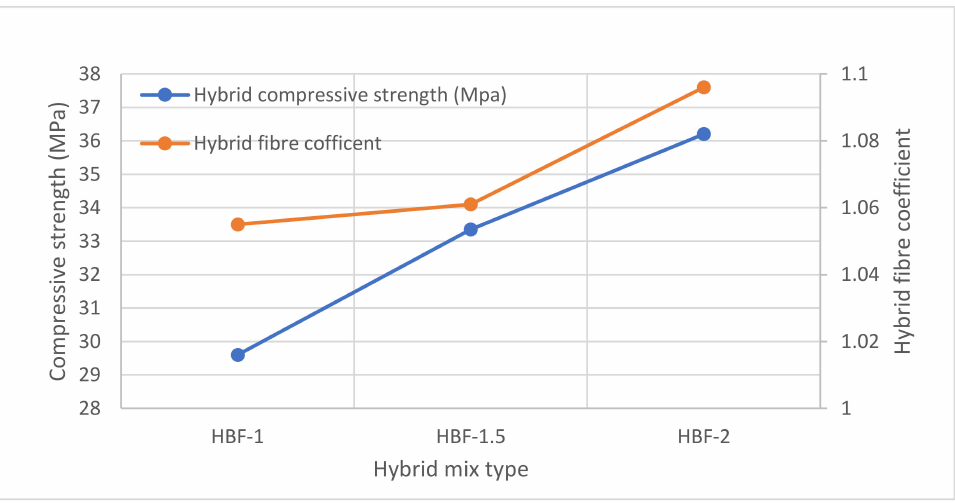
Figure 12. Hybrid fibre coefficient of SCGC’s compressive